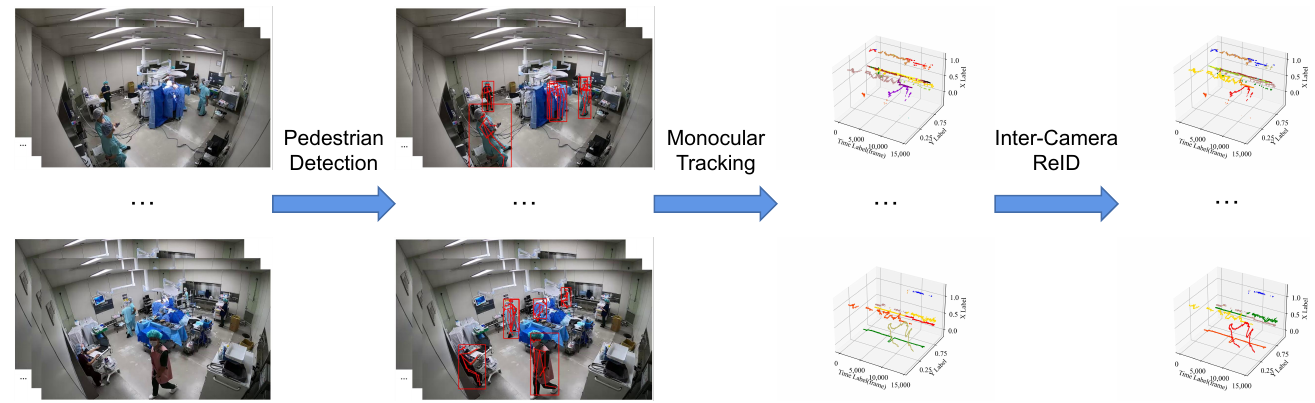
Figure 2. Method flow of the proposed